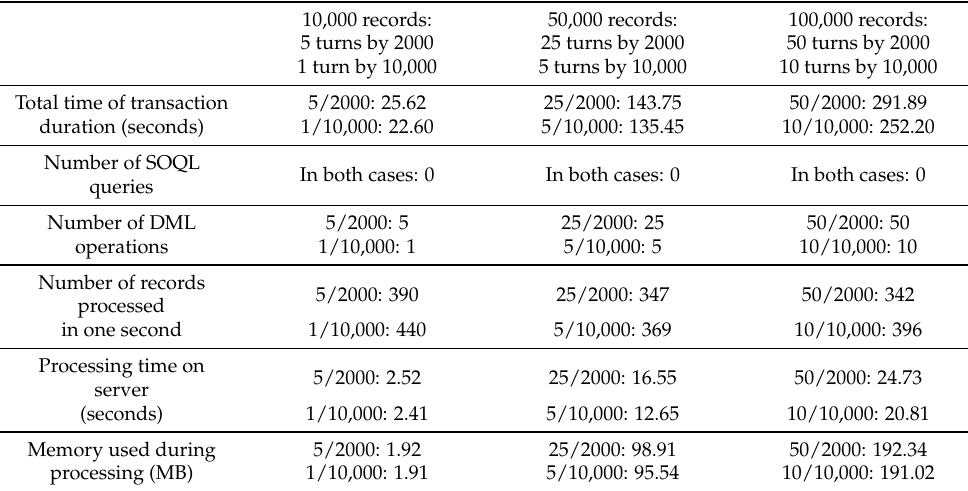
Table 10. Apex Schedulable processing results for insert operation.